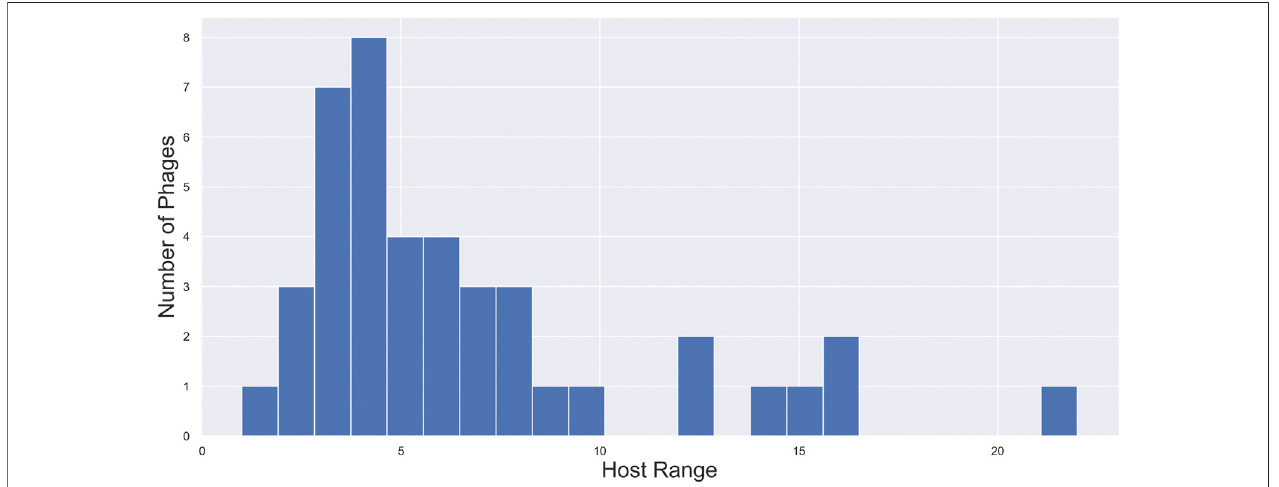
FIGURE 3 | Distribution of host ranges of phages under study. Distribution of the host range of the selected phages across the 46 bacterial hosts available in the dataset. Note that the host range takes on values between 1 and 22, but only 7 of the 42 phages can infect more than 10 bacterial strains.